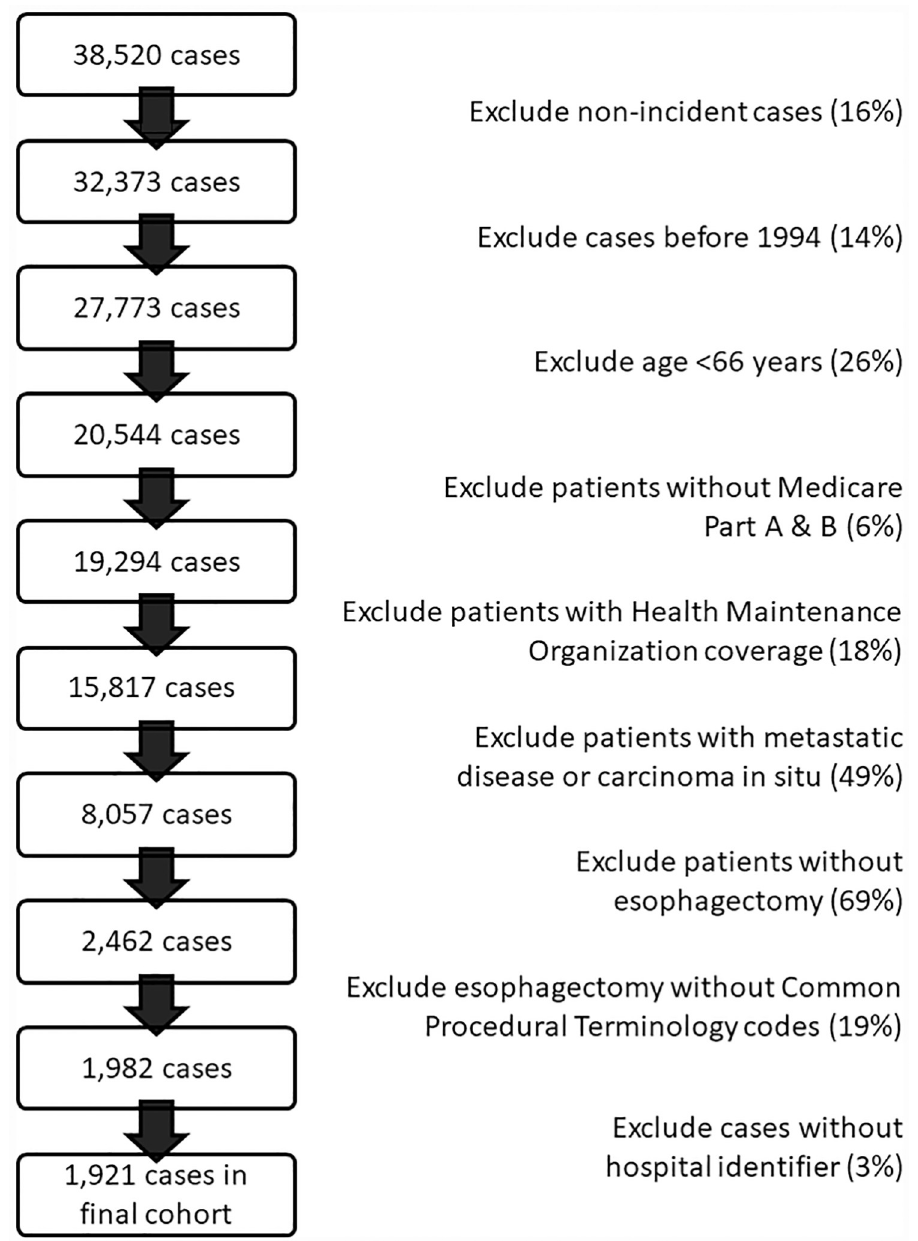
Fig 1. Stepwise identification of cohort. The proportion of patients excluded at each step is provided in parentheses.